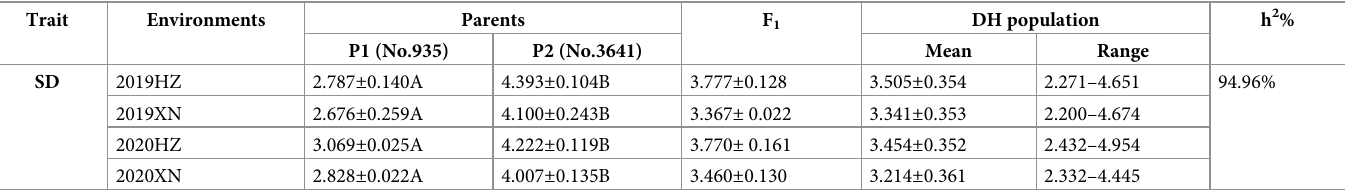
Table 2. Variance analysis of parental SD.